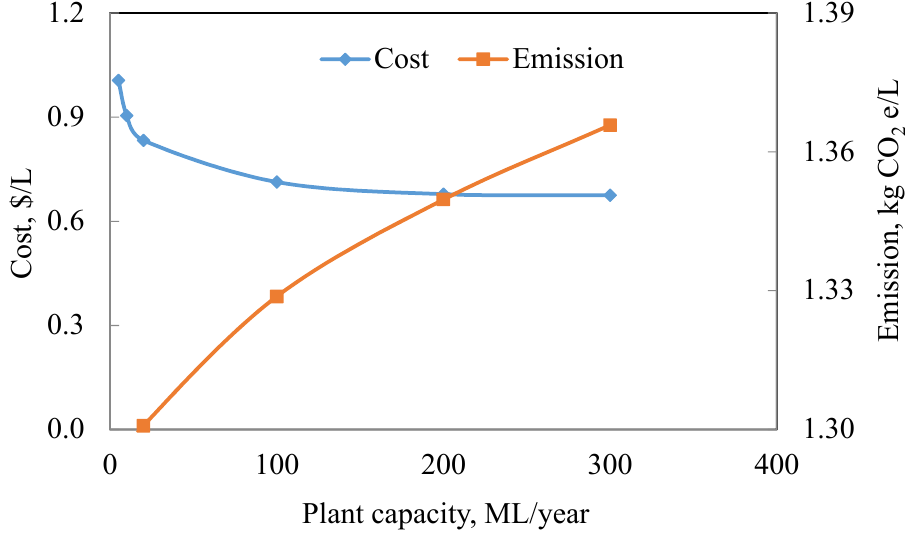
Figure 8. Effect of ethanol plant capacity on production cost and emission.